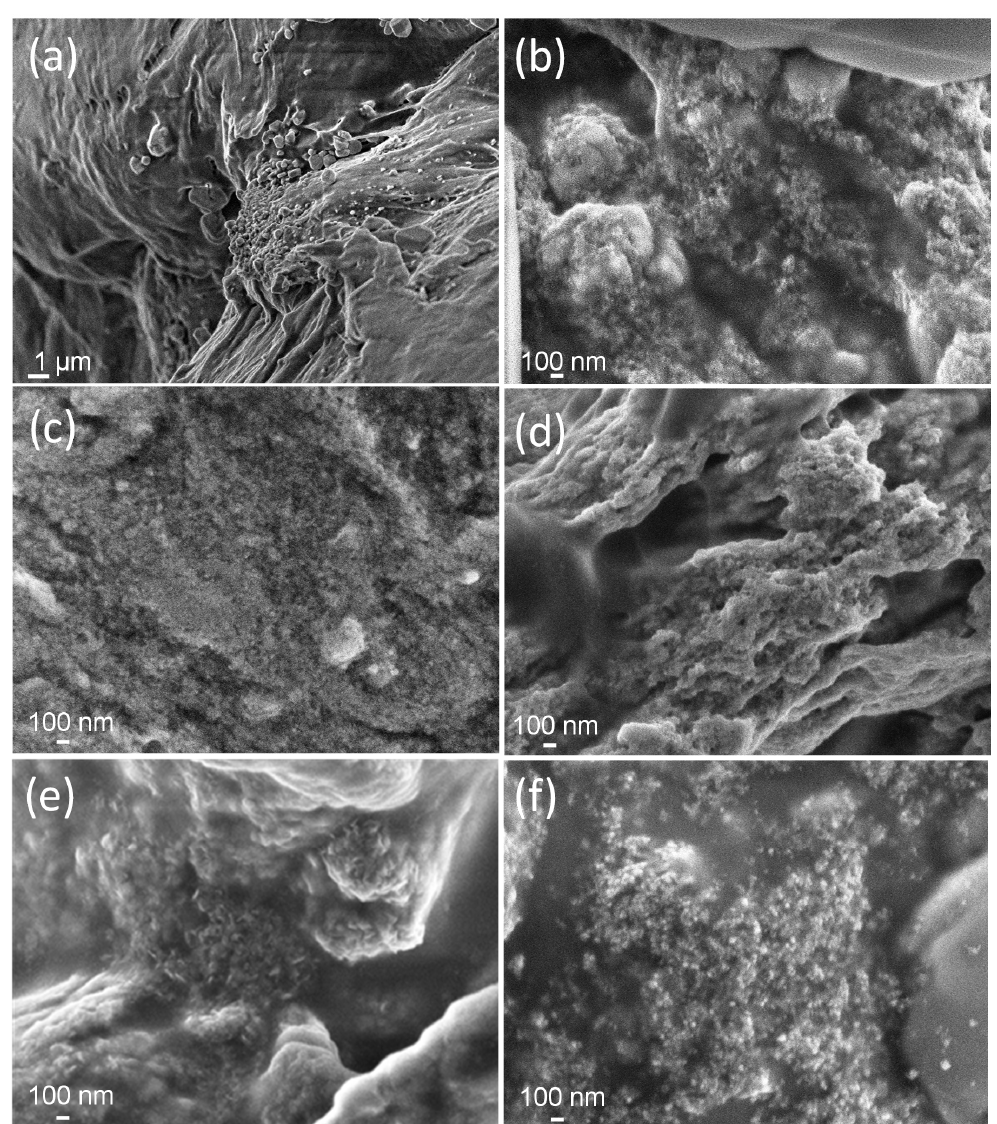
Figure 4. SEM micrographs of PEO/Fe-oxide gels obtained from suspensions with various Fe 3+ content at various doses: ( a ) 5 wt% Fe 3+ at 50 kGy; ( b ) 20 wt% Fe 3+ at 50 kGy; ( c ) 5 wt% Fe 3+ at 130 kGy; ( d ) 20 wt% Fe 3+ at 130 kGy; ( e ) 5 wt% Fe 3+ at 300 kGy; ( f ) 20 wt% Fe 3+ at 300 kGy. All precursor suspensions ( d ) 20 wt% Fe 3 + at 130 kGy; ( e ) 5 wt% Fe 3 + at 300 kGy; ( f ) 20 wt% Fe 3 + at 300 kGy. All were prepared from 1.85 wt% PEO solutions and with 0.2 M 2-propanol.